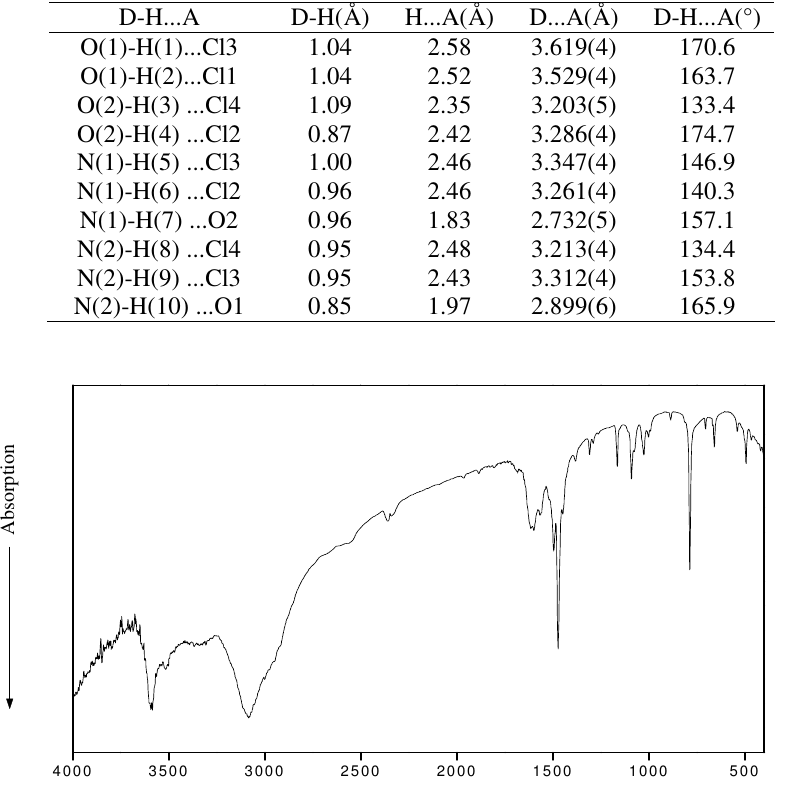
) -C H NH ] ZnCl .2H O. 3 2 6 3 3 2 4 2